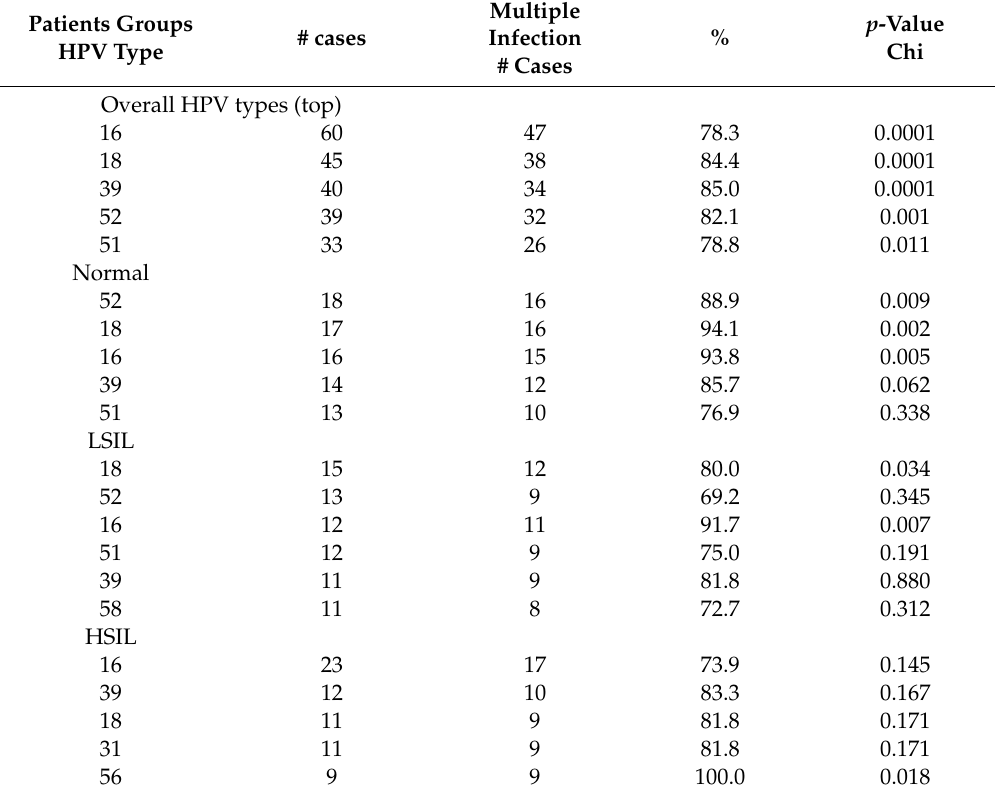
Table 3. HPV prevalence and its association to multiple HPV infections among Pap smear groups at the first